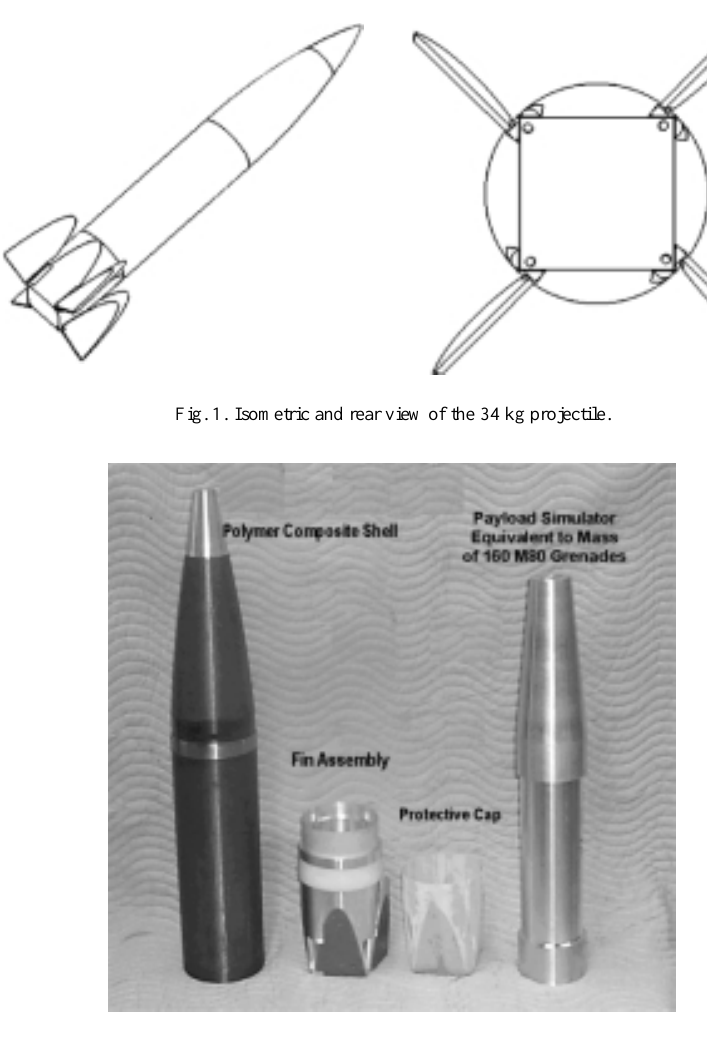
Fig. 2. Components of a 34 kg test